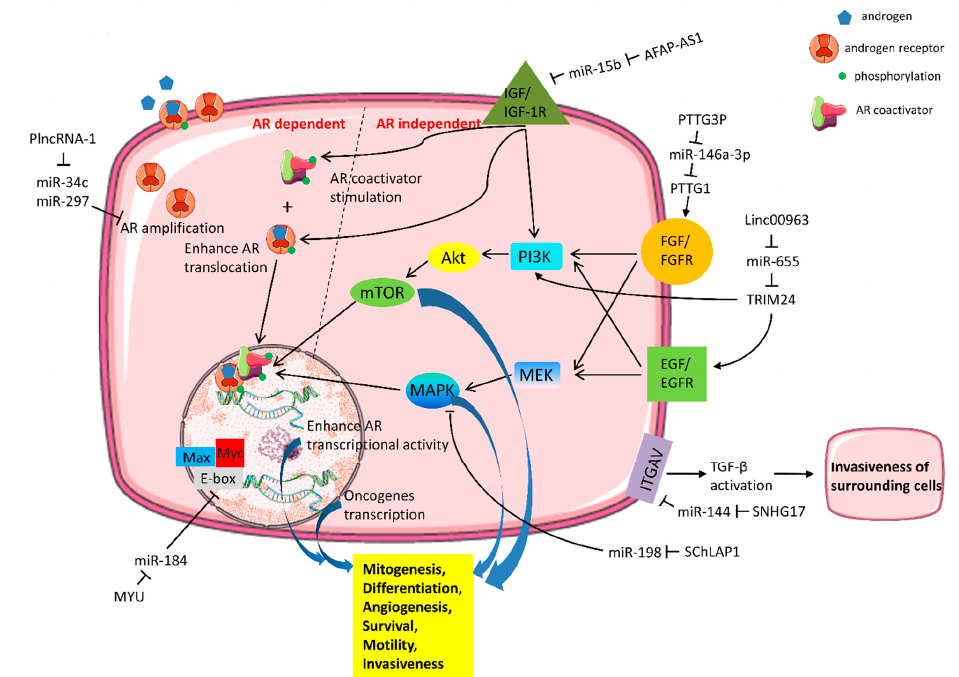
Figure 1. The mechanisms of actions for long-non-coding RNA (lncRNA) and microRNA (miRNA) in androgen receptor (AR) independence/crosstalk signaling in castration-resistant prostate cancer cells. A number of miRNAs that are regulated by lncRNAs and involve the activation of AR crosstalk (AR dependent) and AR bypass (AR independent) signaling axis are demonstrated and further discussed in the present manuscript.